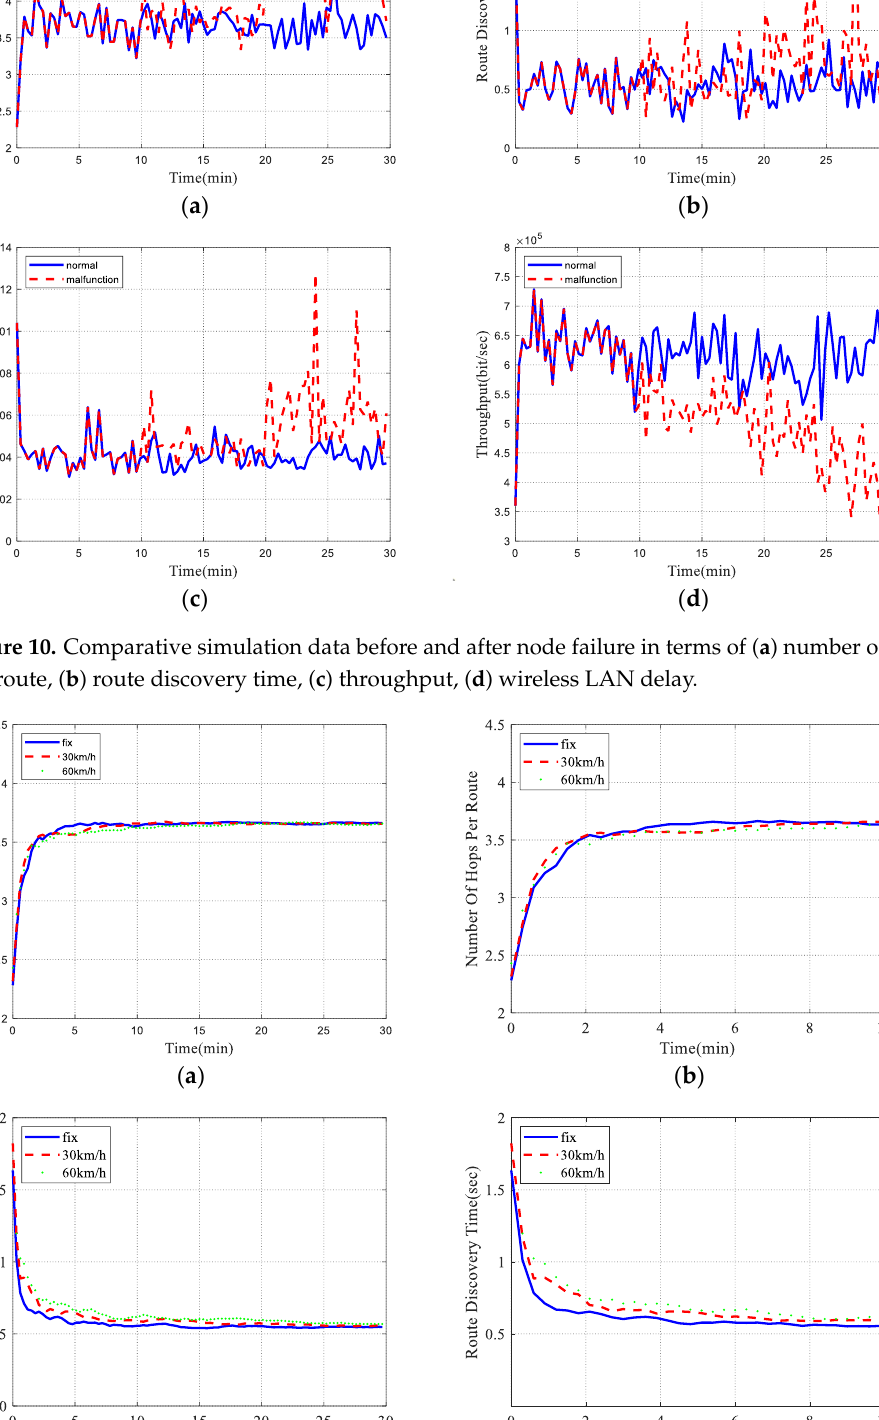
Figure 11. Effect of different speeds on communication stability. ( a ) number of hops per route, ( b ) local enlargement of a, ( c ) route discovery time, ( d ) local enlargement of c.